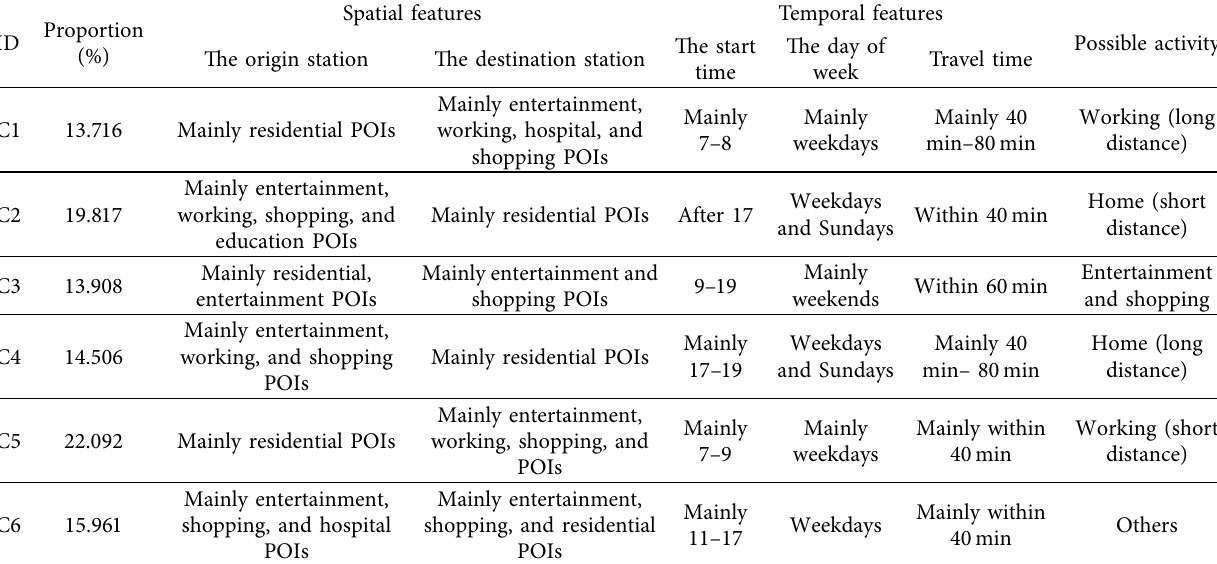
Table 2: Characteristics of mobility